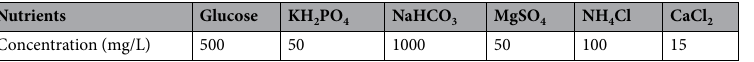
Table 5. The composition of added